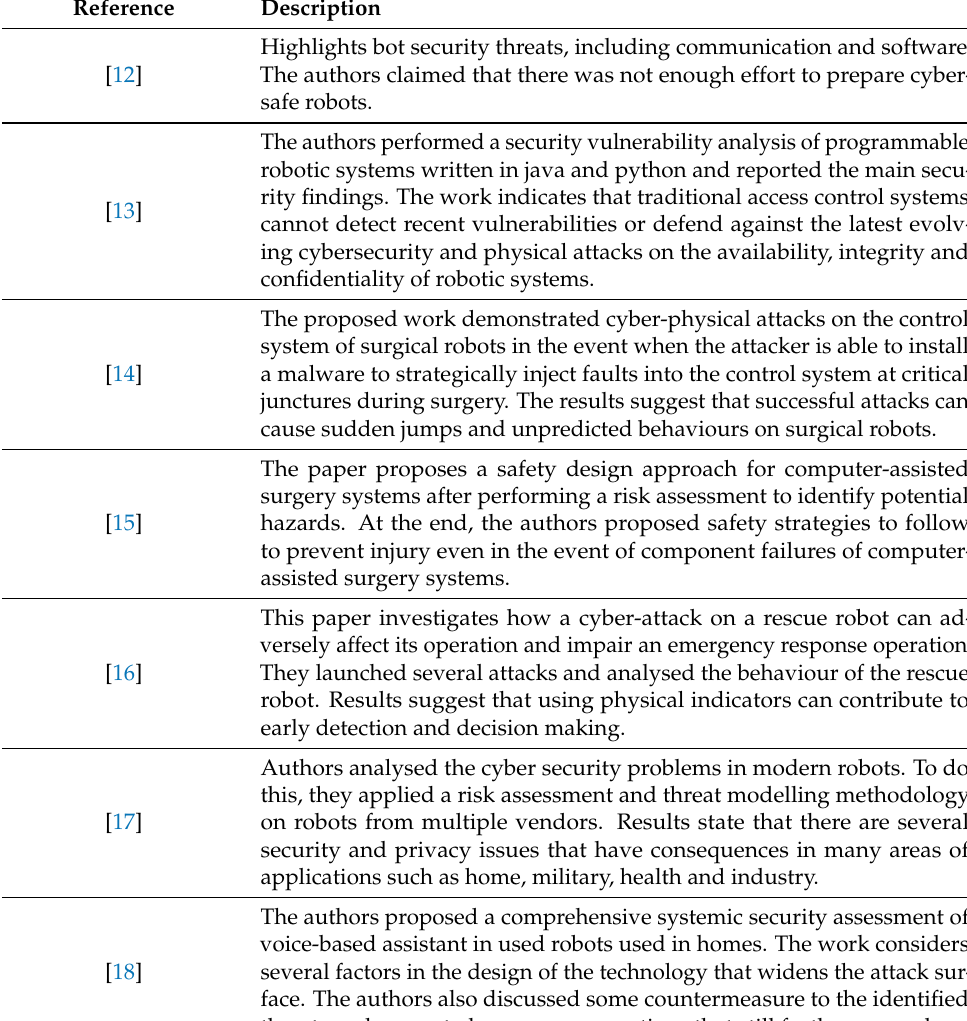
Table 1. Summary of related